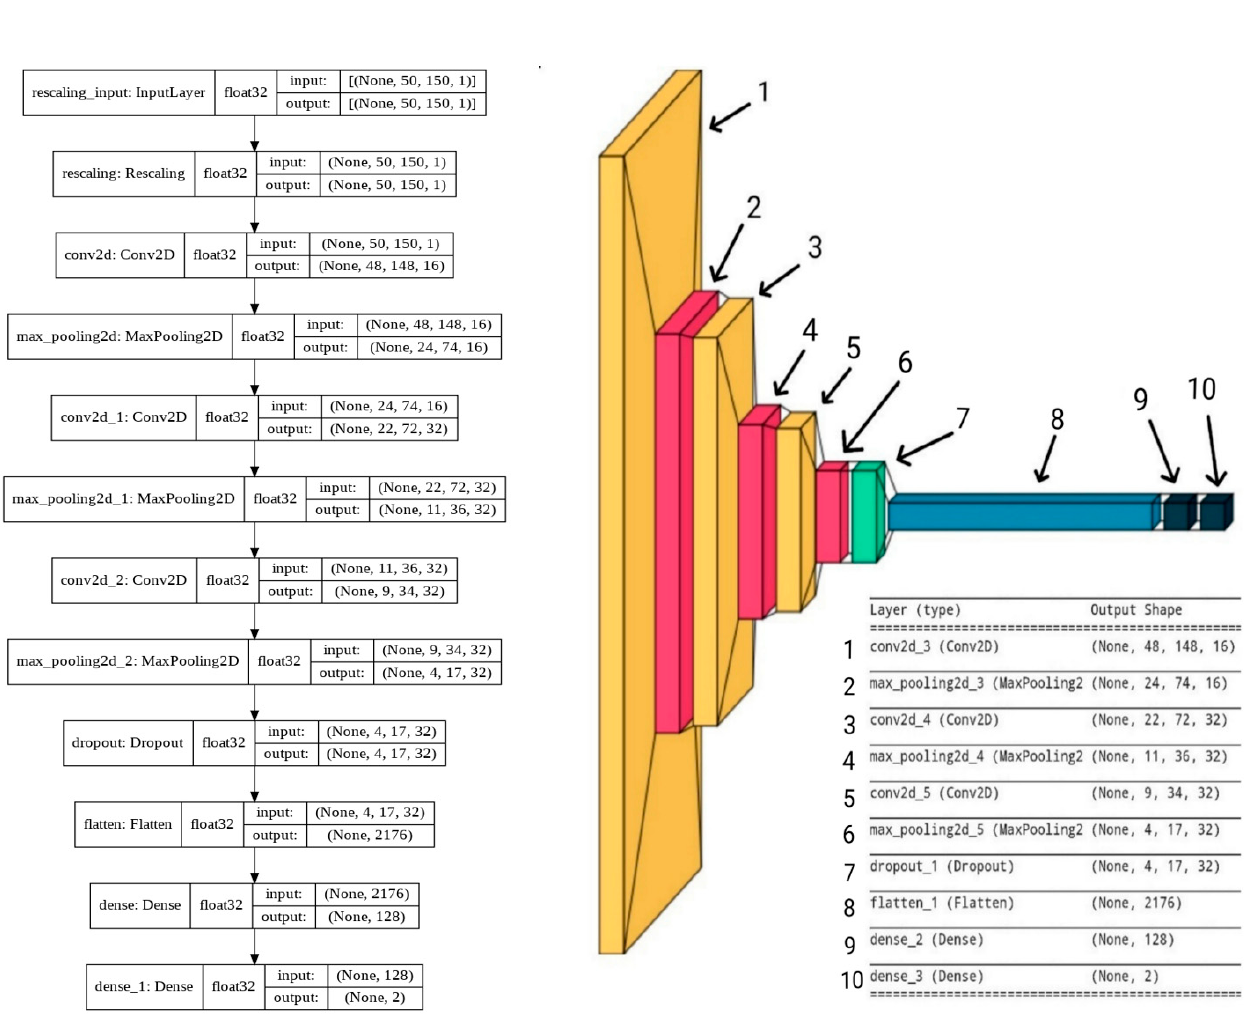
Figure 6. Architecture of the designed CNN.